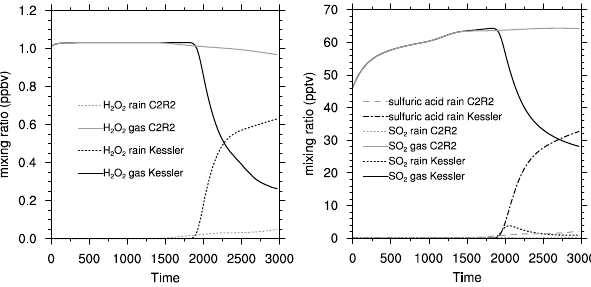
Figure 6. HaRP case: time evolution of the mixing ratio below the cloud (250 m above sea 2 Fig. 6. HaRP case – time evolution of the mixing ratio below the level) for hydrogen peroxide in gas phase and in rainwater (left), for sulphur dioxide in gas 3 cloud (250ma.s.l.) for hydrogen peroxide in gas phase and in rain- phase and in rainwater, and for sulphuric acid in rainwater (right) for both cases: Kessler 4 water (left); and for sulphur dioxide in gas phase and in rainwater, (black lines) and C2R2 (grey lines). 5 and for sulphuric acid in rainwater (right) for both cases: Kessler (black lines) and C2R2 (grey